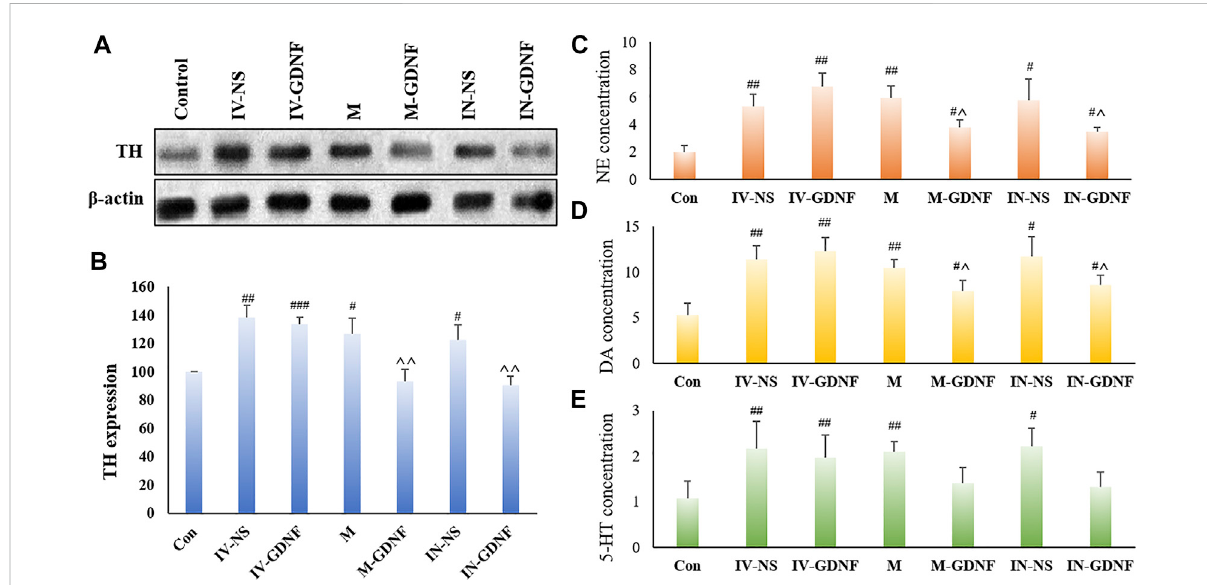
FIGURE 4 Effect of different treatments on morphine neurotransmitters of addiction rats. (A) Representative bands of TH expression. (B) Analysis of TH expression in different groups. (C) . NE concentration measured by HPLC. (D) DA concentration measured by HPLC. (E) . 5-HT concentration measured by HPLC. Means ± SEM, n = 3, # p < 0.05, ## p < 0.01 vs . control group; ^ p < 0.05 vs . IV-SN group. DA, dopamine; HPLC, high performance liquid chromatography; 5-HT, serotonin; NE, norepinephrine; TH, tyrosine